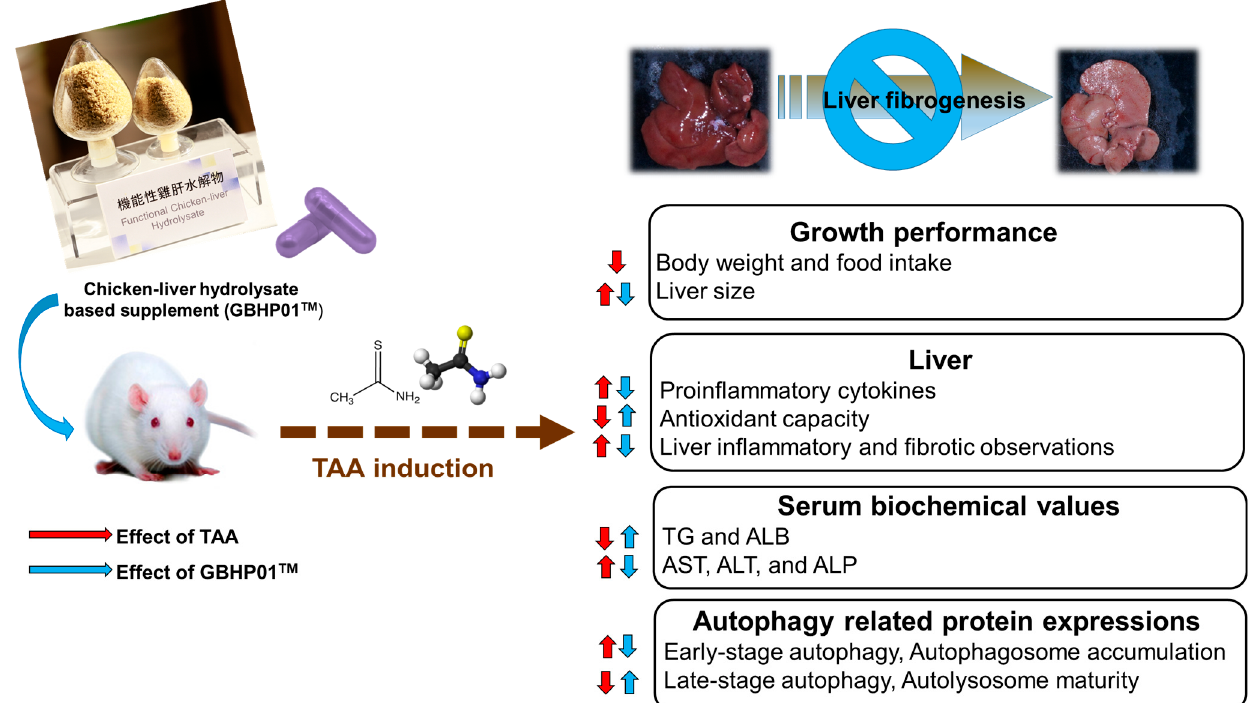
Figure 4. Schematic representation of liver fibrogenesis ameliorated by chicken liver hydrolysate- based supplement (GBHP01 TM ). The up arrow means an increased or upregulated effect; oppositely, the down arrow means a decreased or downregulated effect.